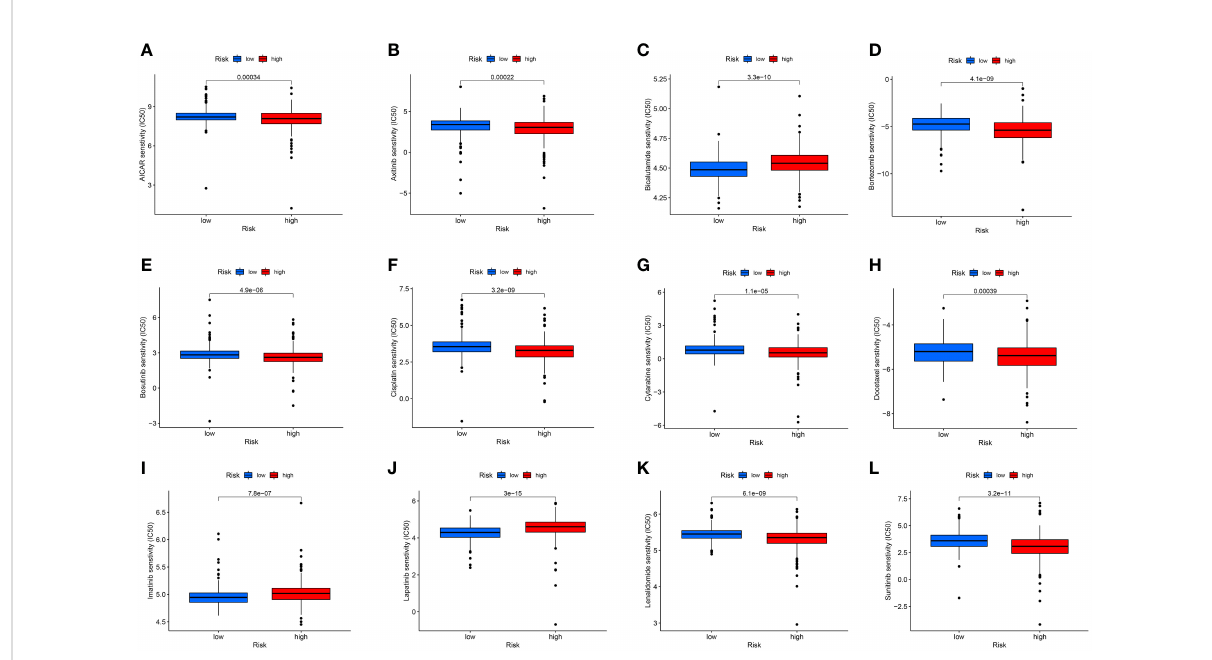
FIGURE 7 The chemotherapy sensitivity of aicar (A) , axitinib (B) , bicalutamide (C) , bortezomib (D) , bosutinib (E) , cisplatin (F) , cytarabine (G) , docetaxel (H) , imatinib (I) , lapatinib (J) , lenalidomide (K) , and sunitinib (L)